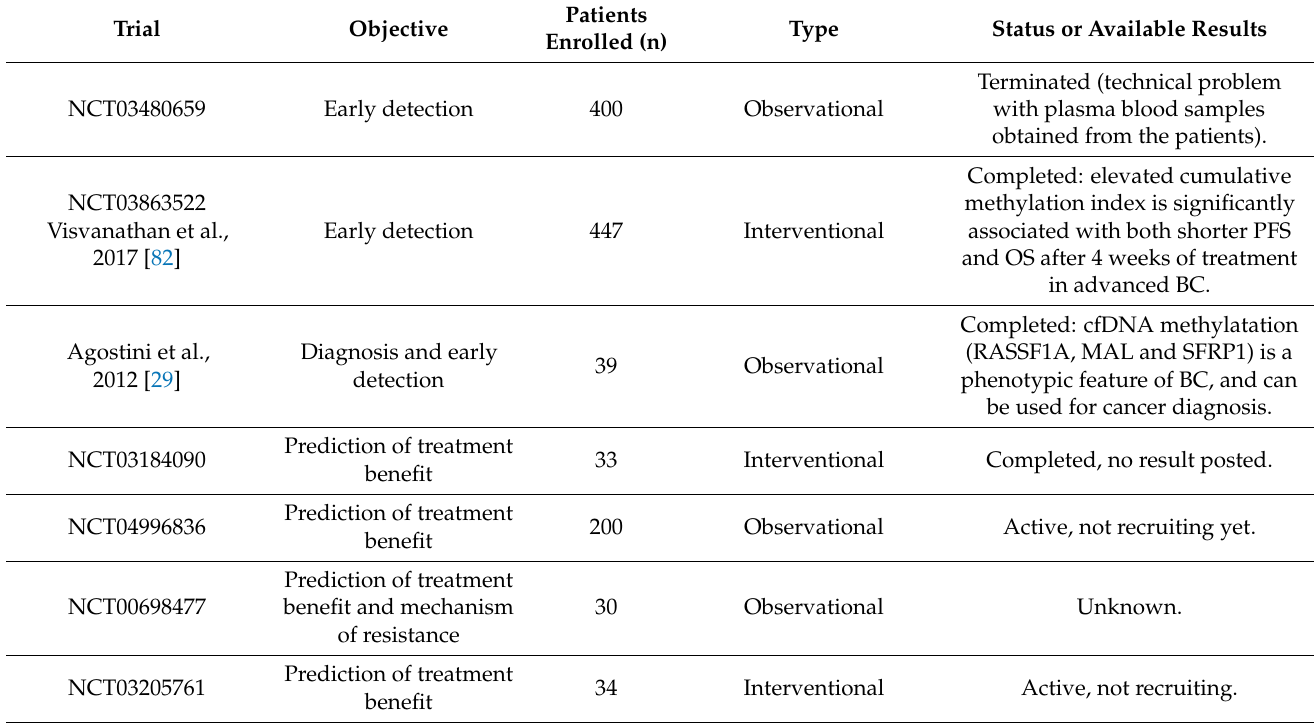
Table 2. Registered clinical trials assessing methylation patterns in cfDNA in breast